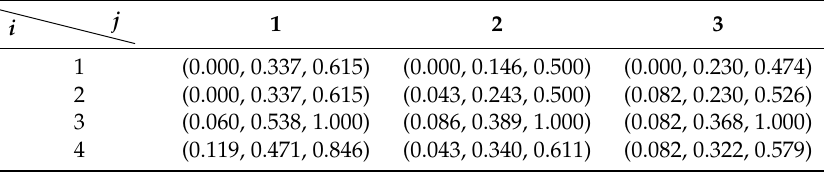
Table 7. Weighted normalized triangular fuzzy numbers of G i , j = ( A i , j , B i , j , C i , j